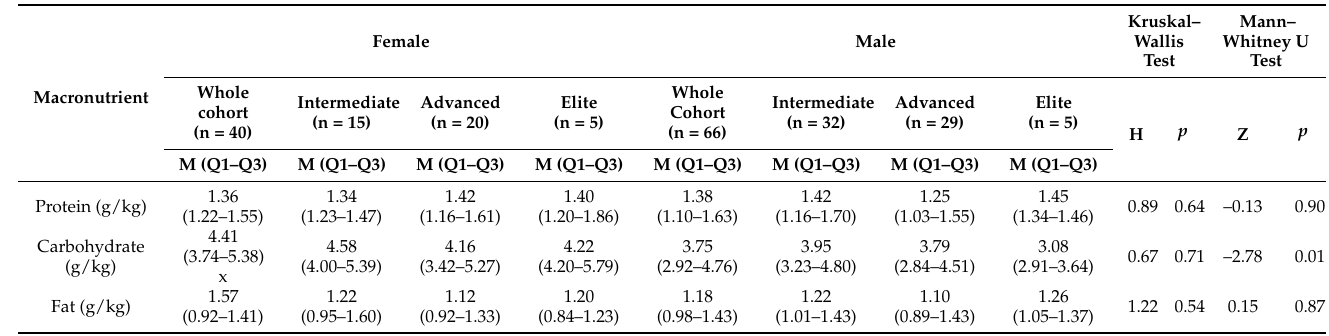
Table 3. Comparison of macronutrient intake per kilogram of body weight between different climbing levels and between genders.